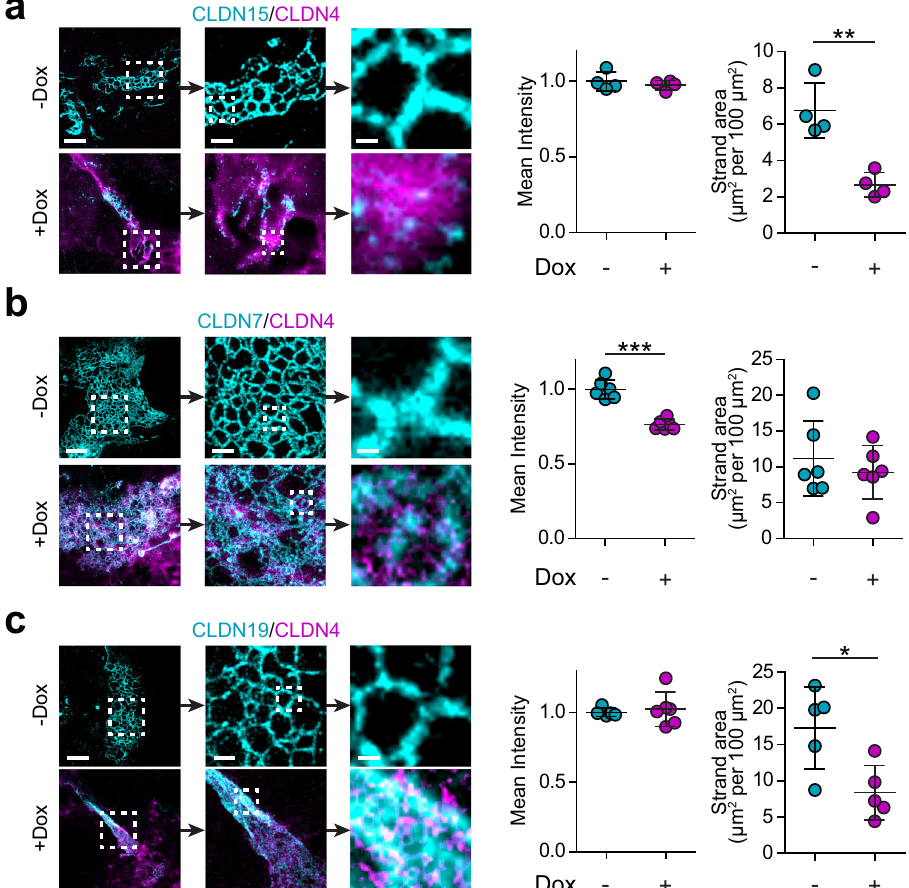
Fig. 6 Claudin-7, 15, and 19 strands are modi fi ed by claudin-4 expression. a STED images show claudin-15 (cyan) meshworks are depolymerized by claudin-4 (magenta), similar to claudin-2 (see Fig. 5). n = 4 each for intensity and area, representative of 3 independent experiments. Two-tail unpaired t -test. ** P = 0.003. b Claudin-7 (cyan) strand intensity is reduced and meshworks are rearranged in response to claudin-4 (magenta) expression. n = 4 each for intensity and area, representative of 3 independent experiments. Two-tail unpaired t -test. *** P < 0.0001. c Claudin-19 (cyan) strand meshworks collapse and form dense bundles upon claudin-4 (magenta) expression. n = 3 each for intensity and area, representative of 3 independent experiments. Two-tail unpaired t -test. * P = 0.019 (area). For each image set, progressive zooms are shown from left to right. Scales: 2 µ m, 500 nm, 100 nm. In all plots, each data point represents the mean of 12 – 16 cells in 1 sample. Data are presented as mean ± SD and included in the Source Data fi